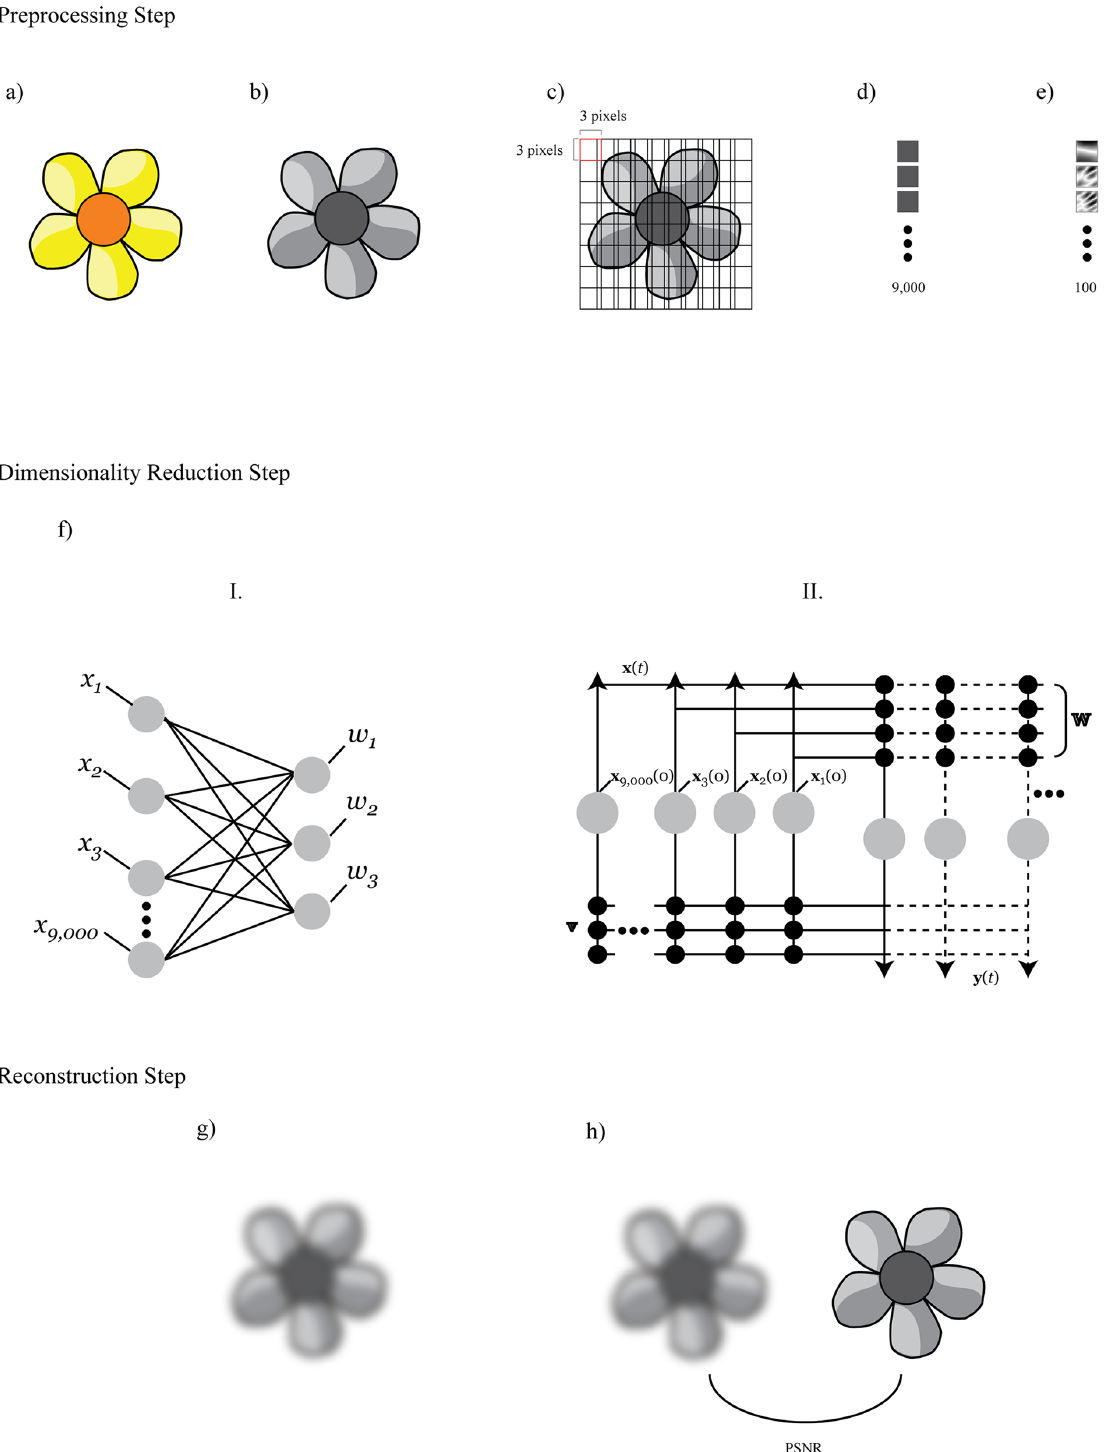
Fig 1. Summary of simulations and architecture of the models. First, original experimental images are loaded (a), then converted to grayscale (b), and sliced into highly overlapping image patches (c). The image patches are ordered into a long vector, which is then centered (d) and whitened (e) using Principal Component Analysis. The pre-processed signal is then input into one of the models (f): ICA (I.) or FEBAM (II.). At the end, the original image is reconstructed from the ICA or FEBAM features (g), and the quality of this reconstructed image is compared to the original using PSNR (h).